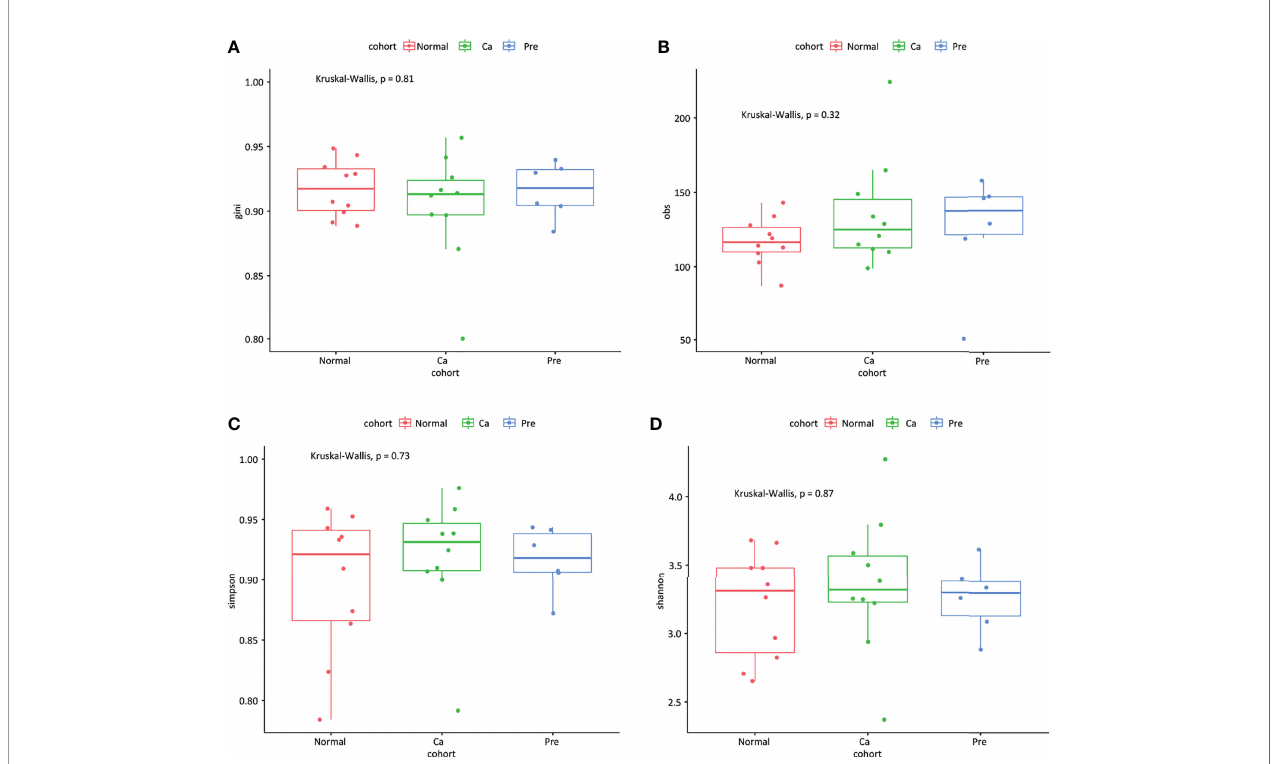
FIGURE 5 | The temporal dynamics of microbiota alpha diversity; (A) gini index; (B) obs index; (C) Simpson index; (D) Shannon